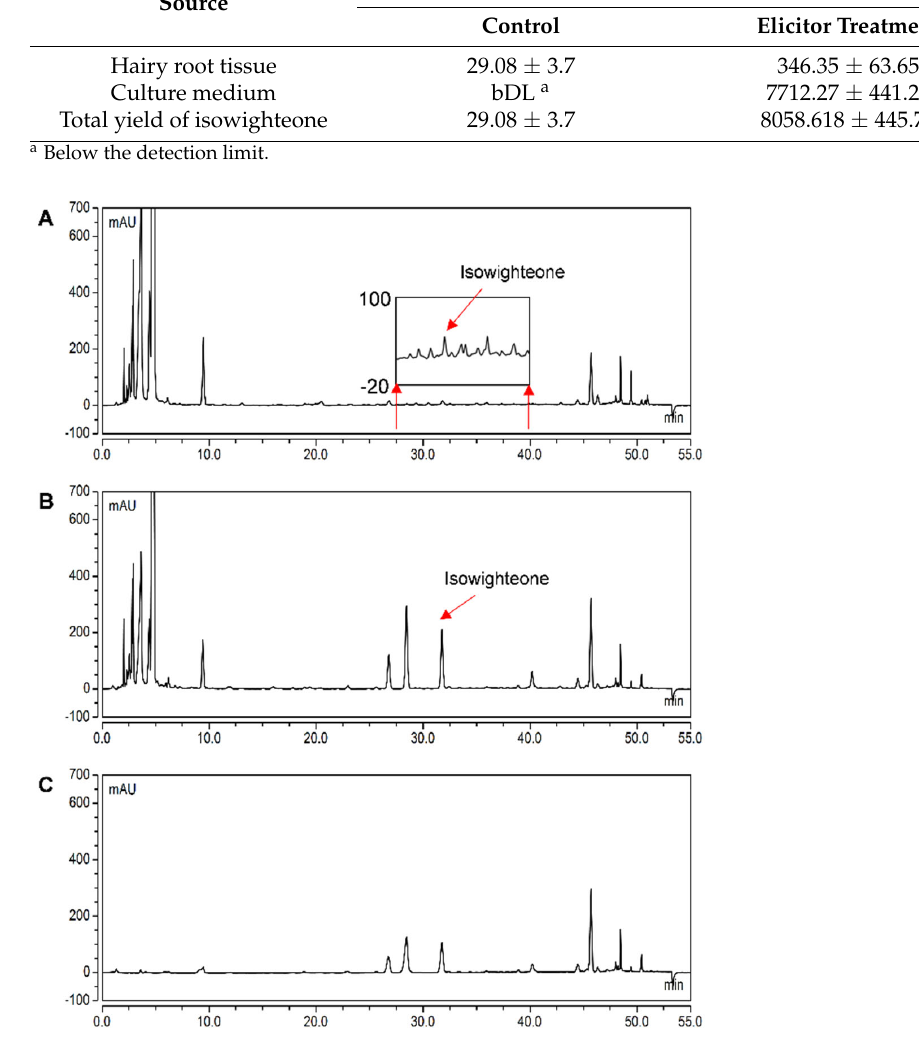
Figure 6. Comparison of isowighteone yield in hairy root tissues of 12 ‐ day ‐ old pigeon pea hairy roots. HPLC chromatogram of ( A ) non ‐ elicited hairy root tissue extracted using 70% ethanol; ( B ) 144 h elicited hairy roots extracted using 70% ethanol; and ( C ) 144 h elicited hairy roots extracted using ethyl acetate. All chromatograms were monitored at 260 nm.